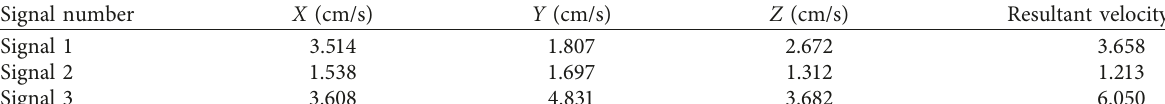
Table 5: Blasting vibration velocities at monitoring station 3 on May